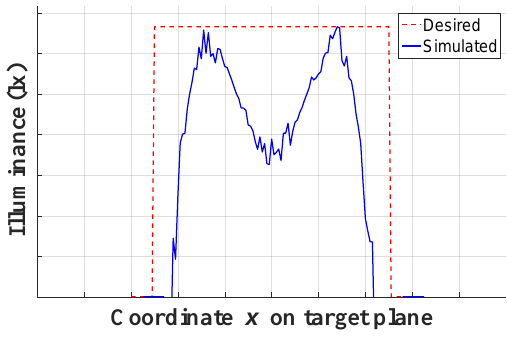
Figure 9. Evaluation function suggested in Barbosa